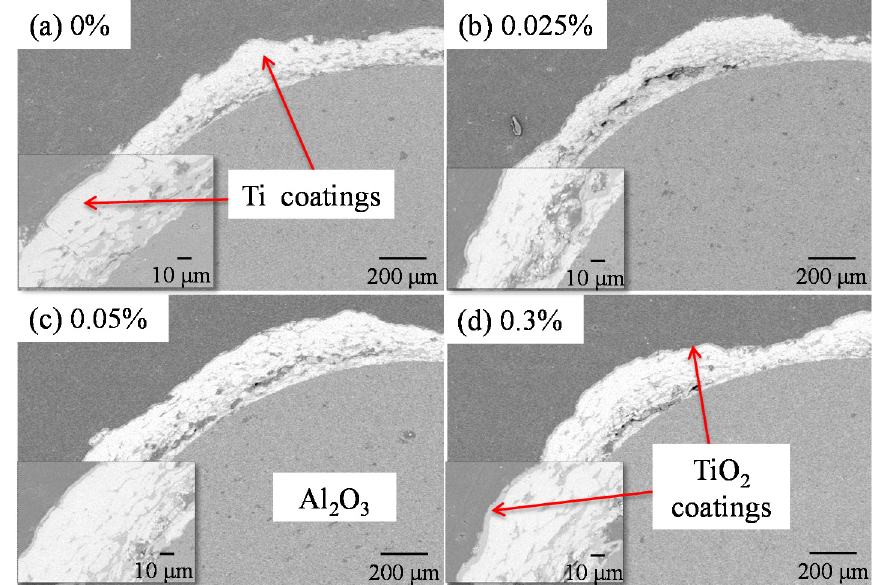
Figure 6. SEM images of cross-sections of M10- x Cr-973 K/10 h samples. ( a ) 0%; ( b ) 0.025%; ( c ) 0.05%; ( d )